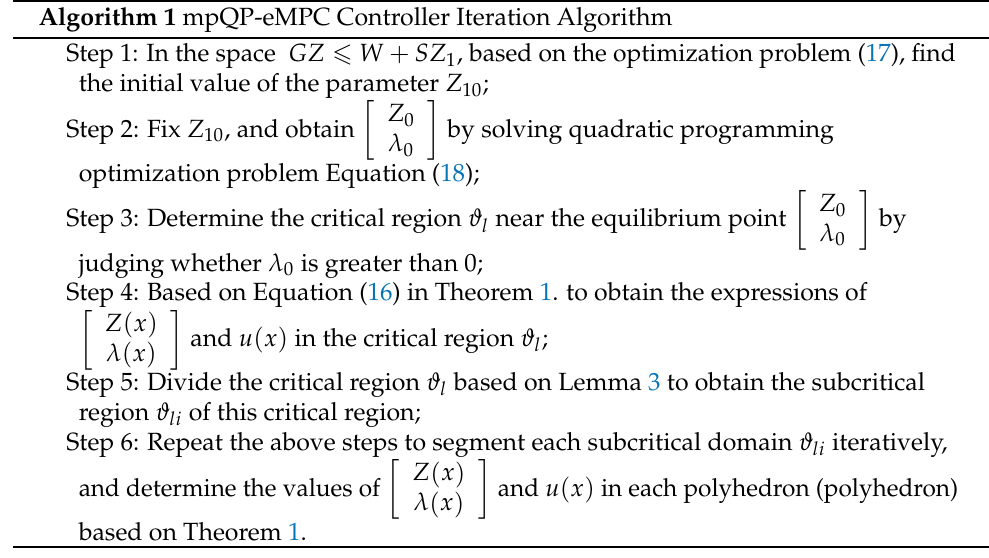
Algorithm 1 mpQP-eMPC Controller Iteration Algorithm